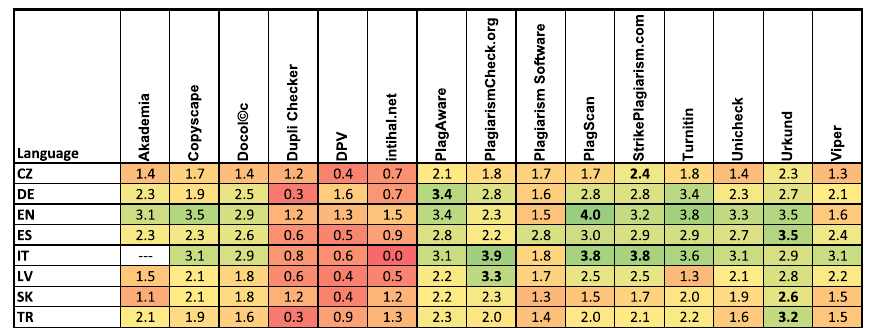
Table 2 Coverage results according to language